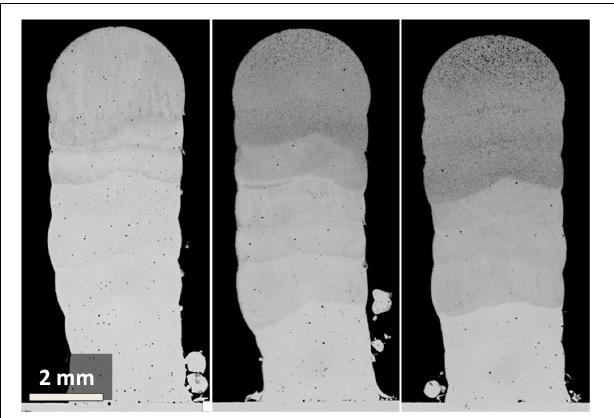
FIGURE 4 | Light microscopic images of the etched as built gradient structures; 5/10/15 at% Al (left); 5/15/25 at% Al (middle); and 10/20/30 at% Al